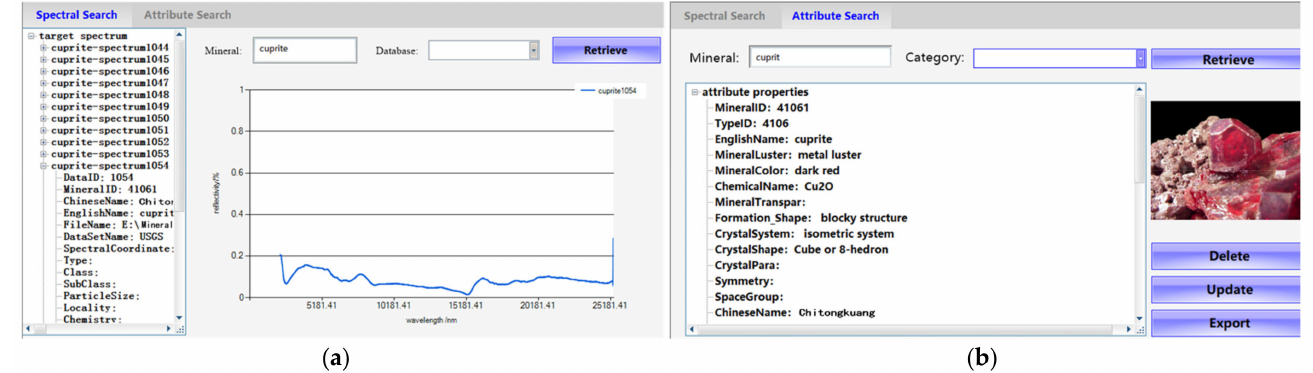
Figure 8. Mineral retrieve of the operating system (search example: cuprite). ( a ) The retrieval interface of the spectral information; ( b ) the retrieval interface of the mineral attribute shows the attribute information and mineral image (cuprite, downloaded from an open